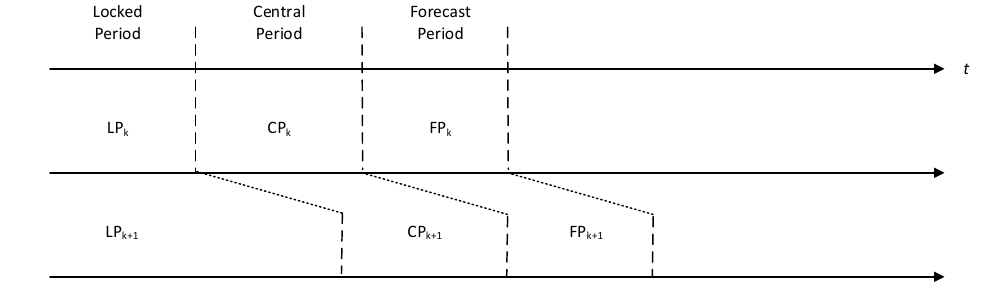
Figure 4. Illustration of the rolling horizon framework